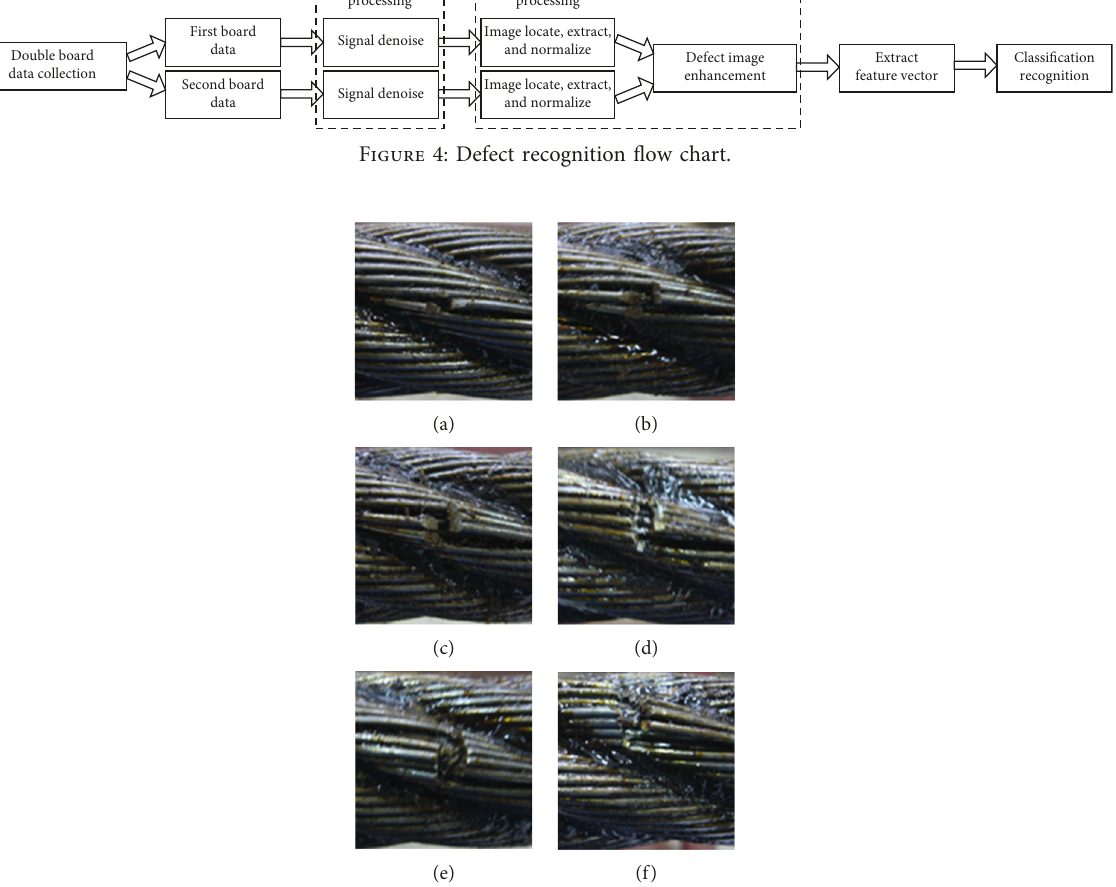
Figure 5: Images of broken wires. (a) One broken wire. (b) Two broken wires. (c) Three broken wires. (d) Four broken wires. (e) Five broken wires. (f) Seven broken wires.